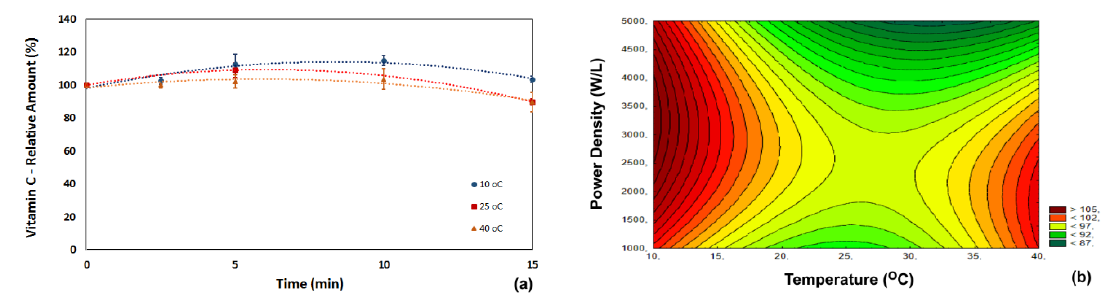
Figure 2. Influence of temperature, power density and processing time on the relative content of vitamin C in acerola juice. ( a ) Process carried out at 5000 W/L; ( b ) process carried out for 15 min.